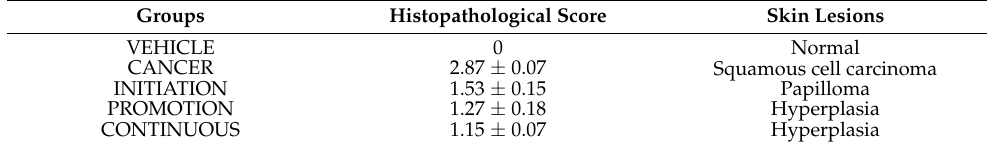
Table 1. Histopathological score based on hematoxylin and eosin (H&E) staining.